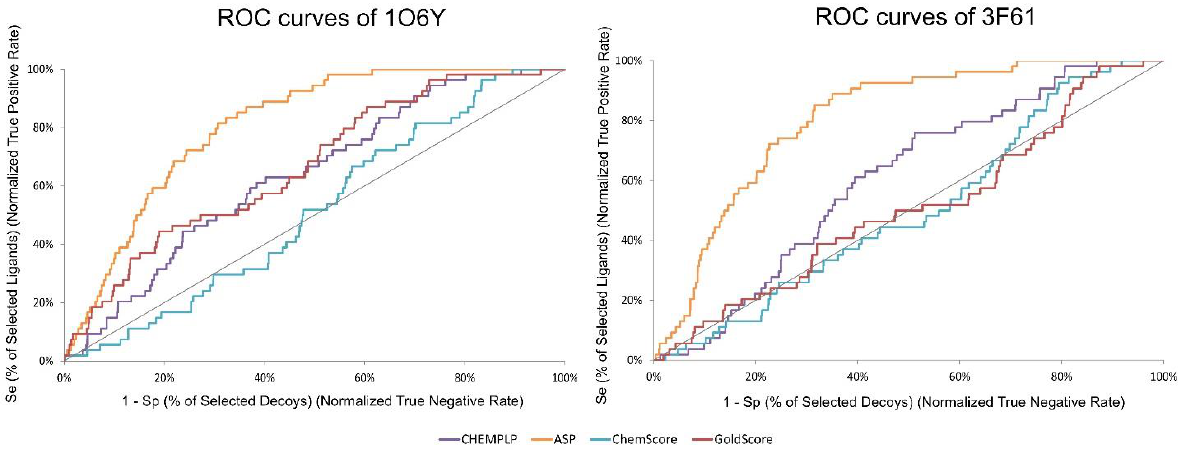
Figure 3. ROC curves obtained for target structures 1O6Y and 3F61 with the different scoring functions used in the active vs. decoys virtual screening evaluation stage.